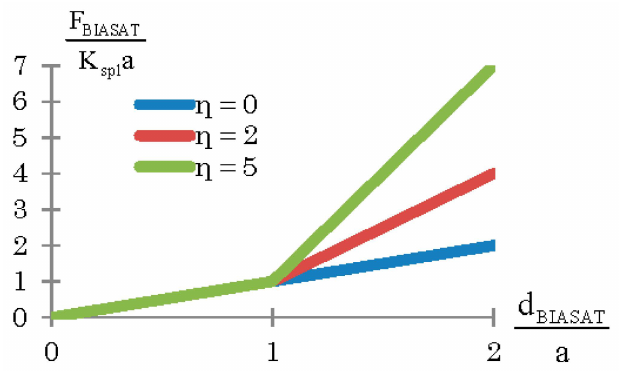
Figure 9. Dimensionless force-deformation graph of BIASAT in passive mode for different η values.